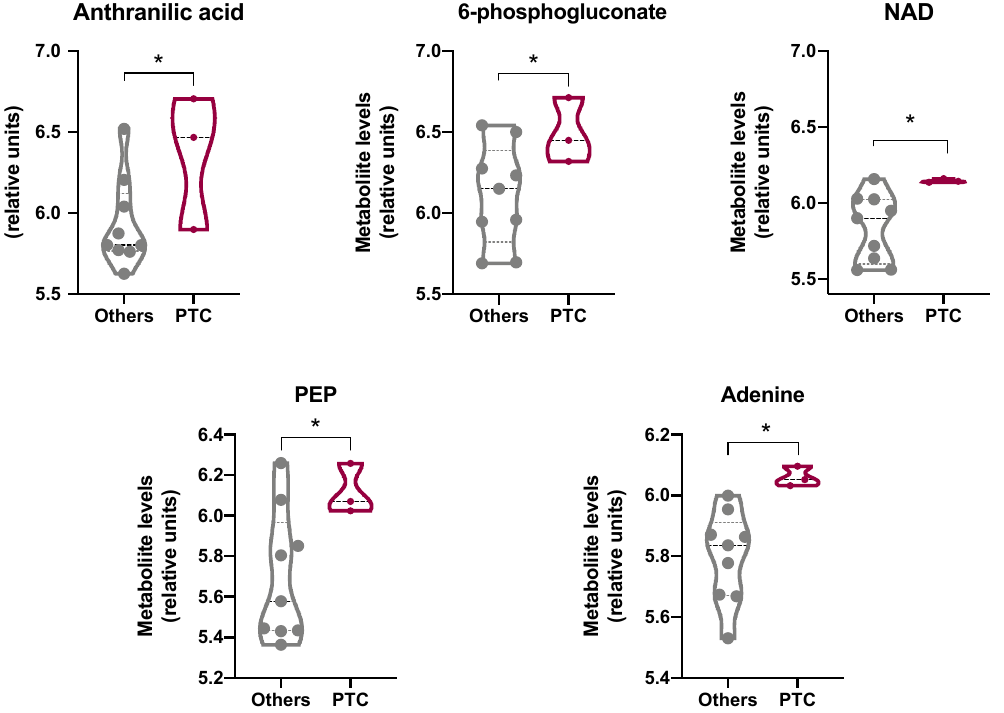
Figure 5. Dissection of the metabolic status of PTCs. We extrapolated from the DepMap portal (https://depmap.org/portal/; accessed on 31 January 2022) the profile of 225 metabolites in 12 thyroid cancer cell lines (i.e., three PTC (i.e., SW579, BCPAP, and BHT101), four FTC (i.e., CGTHW1, FTC238, ML1, TT2609C02), four anaplastic (i.e., 8305C, 8505C, CAL62; FTC133), one medullary (i.e., TT), and one thyroid sarcoma (i.e., S117)). Some of the metabolites involved in tryptophan metabolism (i.e., anthranilic acid, NAD, 6-phosphogluconate, adenine, and PEP) were found significantly higher in PTC cells compared to all the other thyroid cancer cell lines. Each dot in the plots represents the measured value of the indicated metabolite in one single thyroid cancer cell line (Student’s t-test, * p < 0.05 with respect to healthy lobes). Crude and analyzed data are given in Supplementary Tables S7 and S8.